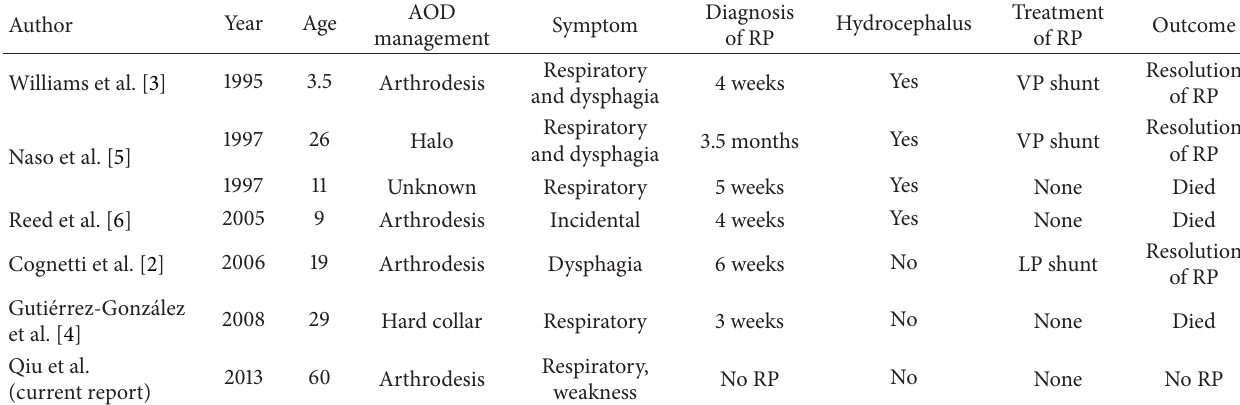
Table 1: Cases of retropharyngeal pseudomeningocele following AOD.